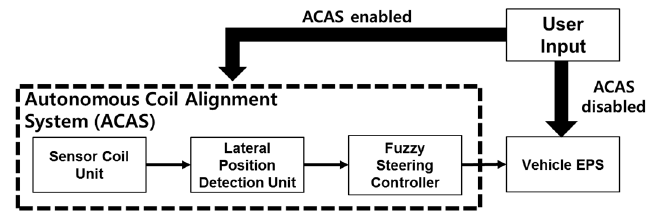
Figure 6. Block diagram of the ACAS.